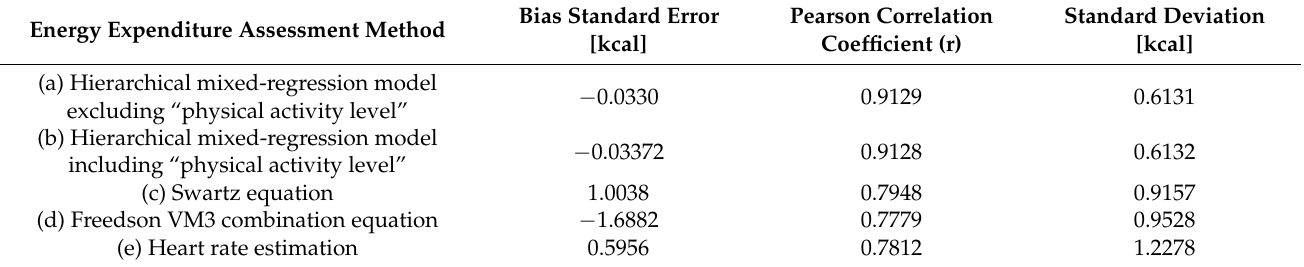
Table 6. Mean of the errors of the total expenditure of the cycle between the methods applied in relation to the energy expenditure by indirect